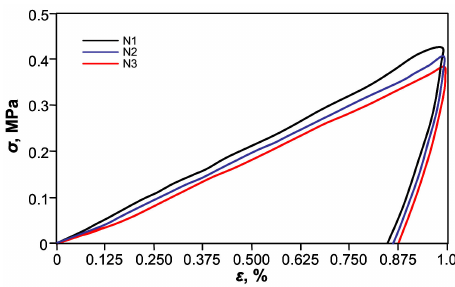
Figure 6. Cyclic tensile stress-strain curves of the crosslinked PETMP-TTT polymer